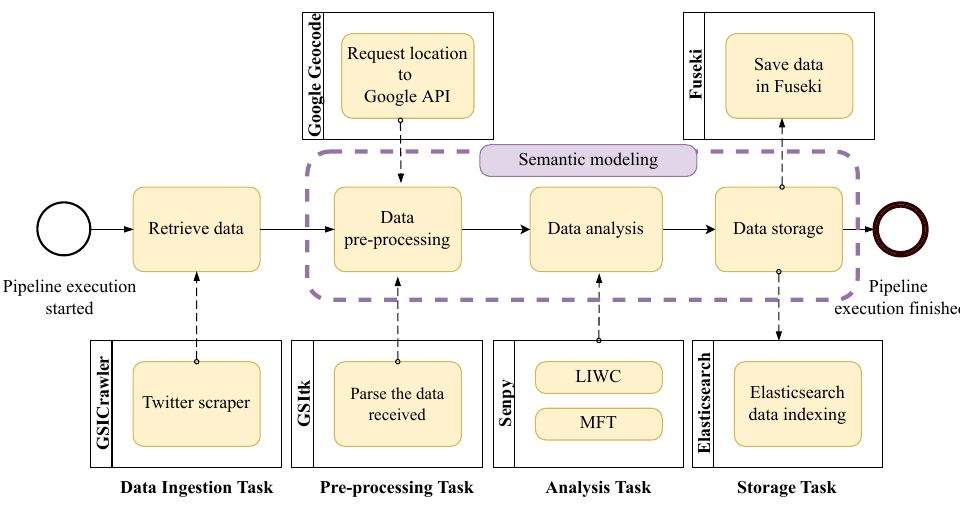
Figure 7. Tasks of the data